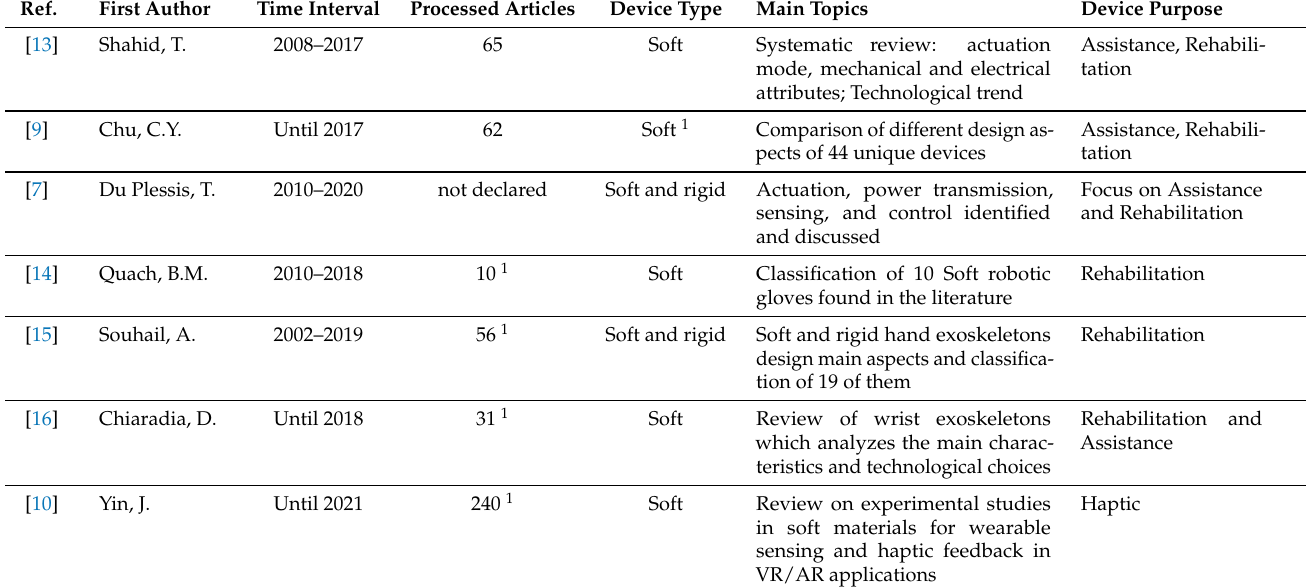
Table 1. Reviews and articles with an in-depth analysis of the state of the art of soft gloves.